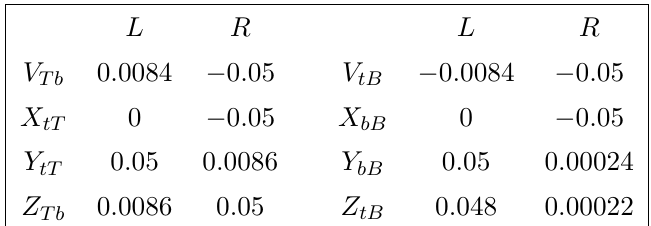
= 0 : 05, s d = 0 : 05 (implying s u R R